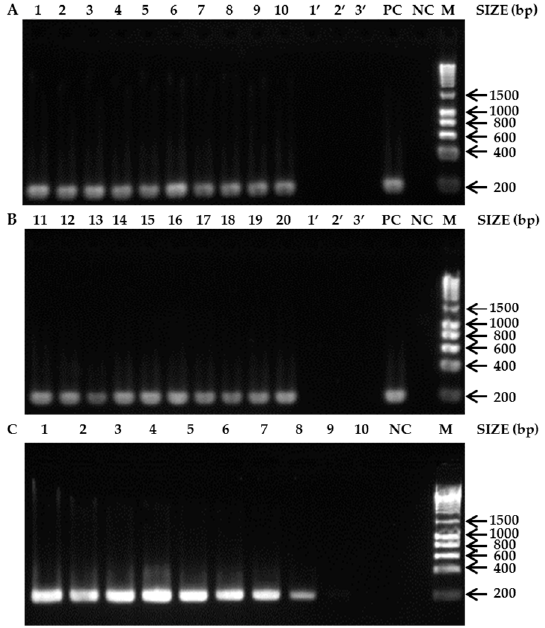
Figure 1. Agarose gels of PCR products. ( A ) A. tumida specimens from its native range and